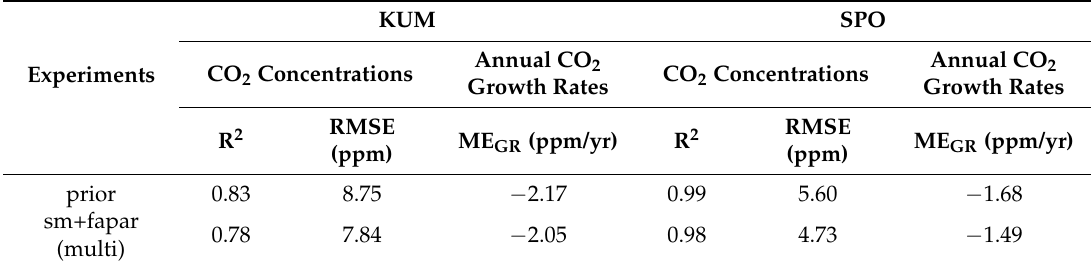
Table 7. Summary of performance metrics for CO 2 concentrations and CO 2 annual growth rates at stations, KUM and